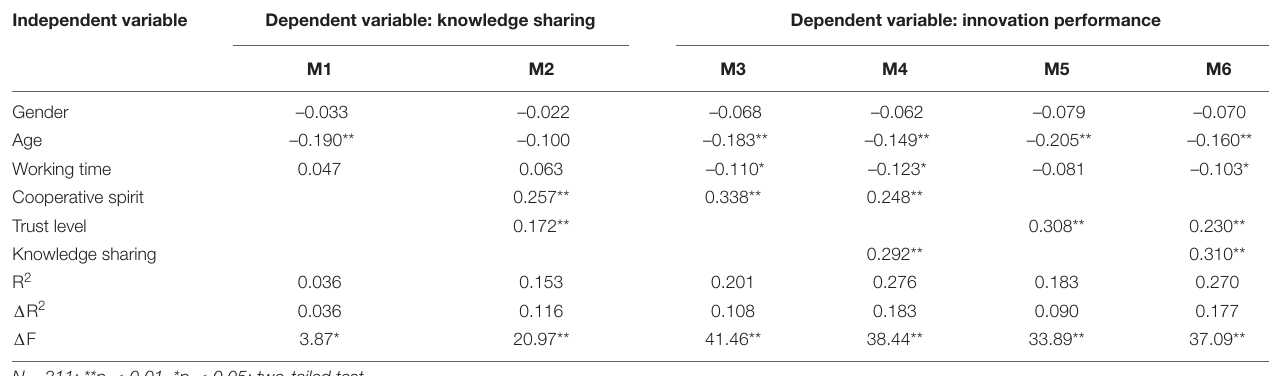
TABLE 6 | The mediating effect of member knowledge sharing on the impact of member relationship on innovation performance.